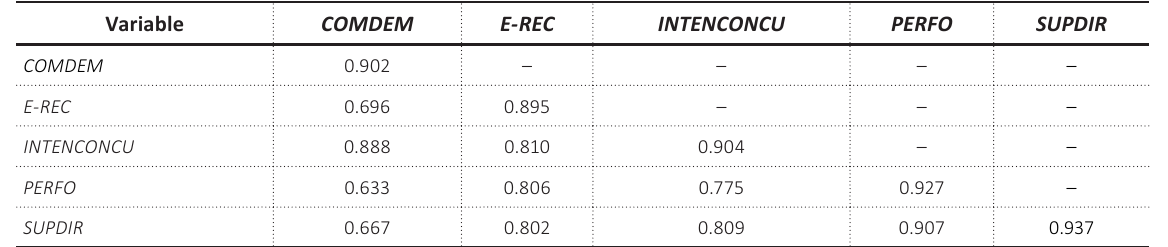
Table 2. Fornell and Larcker criterion